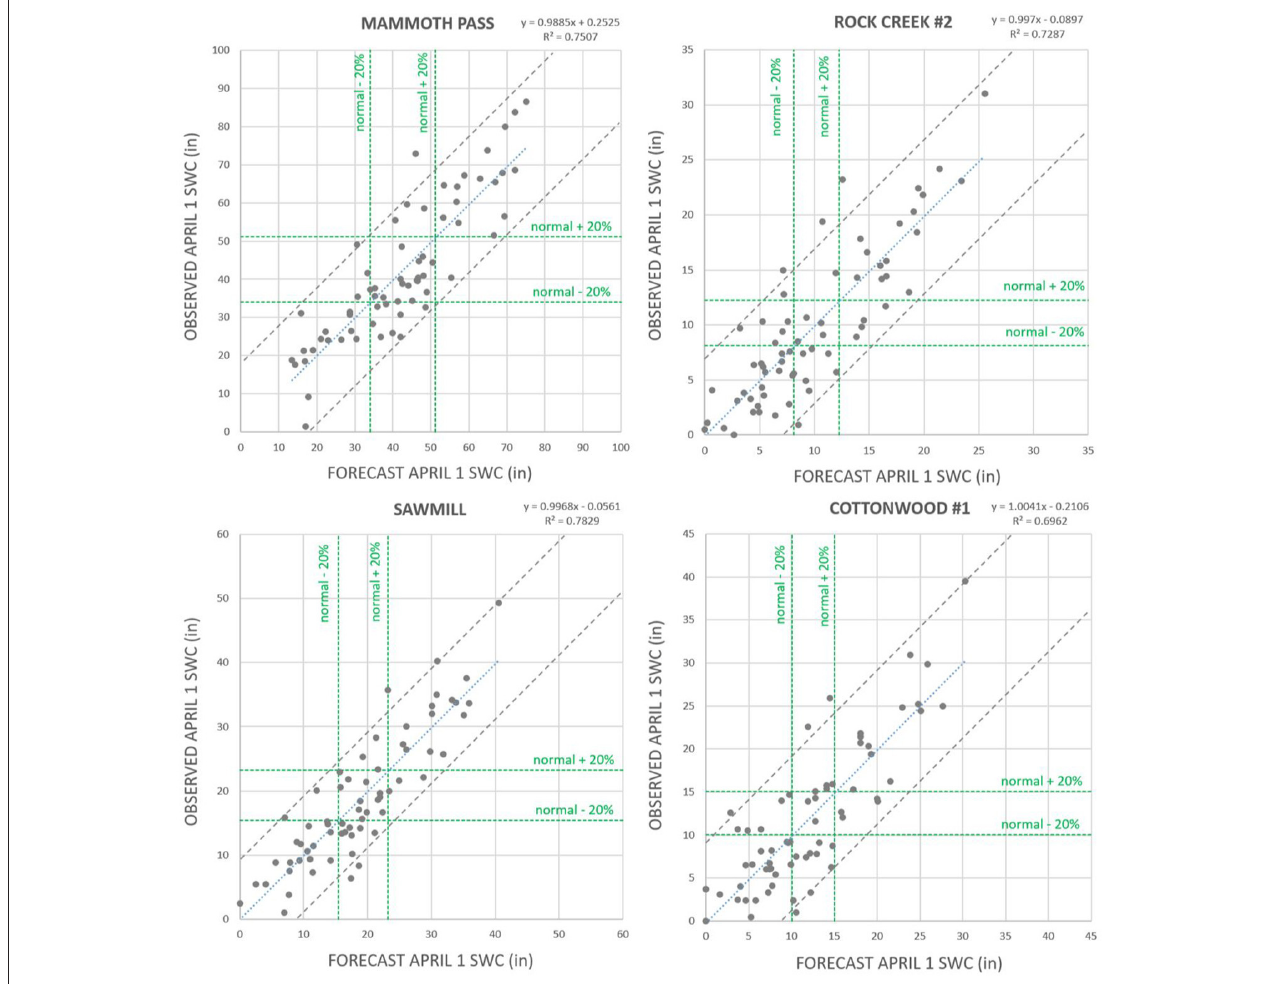
FIGURE 4 | Observed April 1 SWC each year in 1951–2016 plotted against the model’s forecast value, for the four Owens Valley sites. Dashed gray lines indicate the 95% confidence interval. Dashed green lines indicate a 20% deviation from the normal value, separating between the categories dry, normal, and